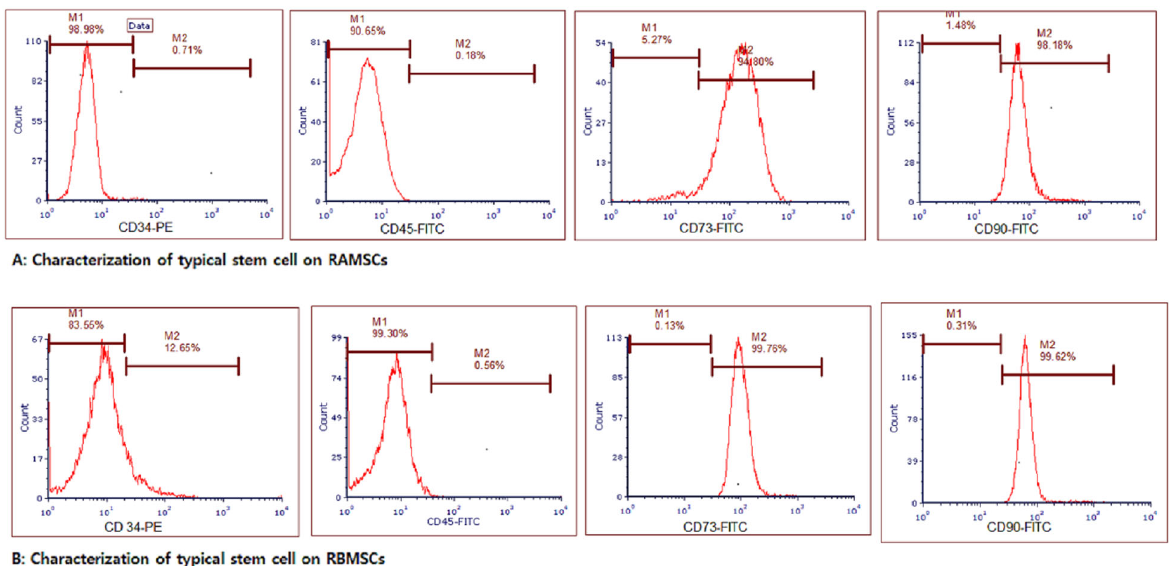
Fig. 2 Characterization of the typical stem cell (AMSCs and BMSCs) surface markers CD31, CD34, CD73, and CD90 using fl ow cytometry. A Hematopoietic progenitor cell marker CD34 and pan-leucocyte marker CD45 in BMSCs are ignorable percentages in BMSCs. Surface markers CD73 and CD90 are used as positive markers to identify